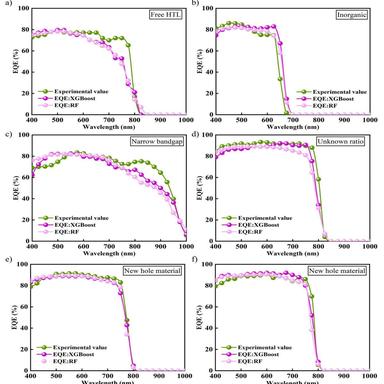
ML Prediction of the EQE curves for five perovskite devices.a) PSC without hole transport layer, from Ref.; b) PSC with inorganic perovskite, from Ref.; c) PSC with narrow-bandgap perovskite, from Ref.; d) PSC with unknown elemental ratios of perovskite, from Ref.; e)-f) PSC with new hole material, from Ref .